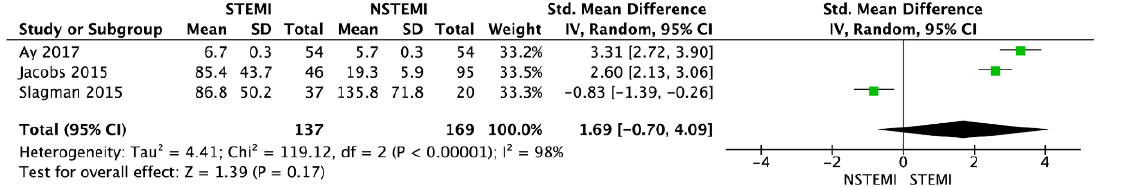
Figure 4. Forest plot of copeptin levels in the STEMI and NSTEMI groups. The center of each square represents the weighted standard mean difference for individual trials, and the corresponding horizontal line stands for a 95% confidence interval. The diamonds represent pooled results. Legend: CI = confidence interval; SMD = standard mean difference.